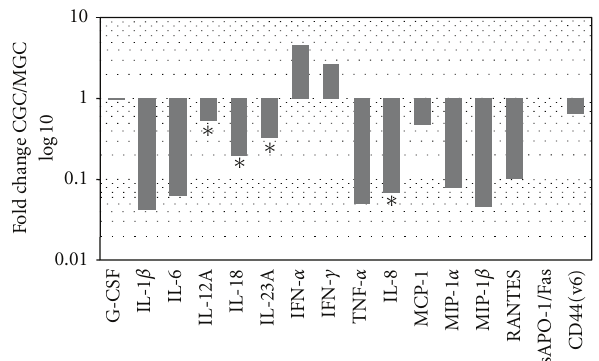
Figure 2: Di ff erential expression of measured protein transcripts in cumulus and mural granulosa cells. ∗ Di ff erences in expression were statistically significant. CGC: cumulus granulosa cells, MGC: mural granulosa